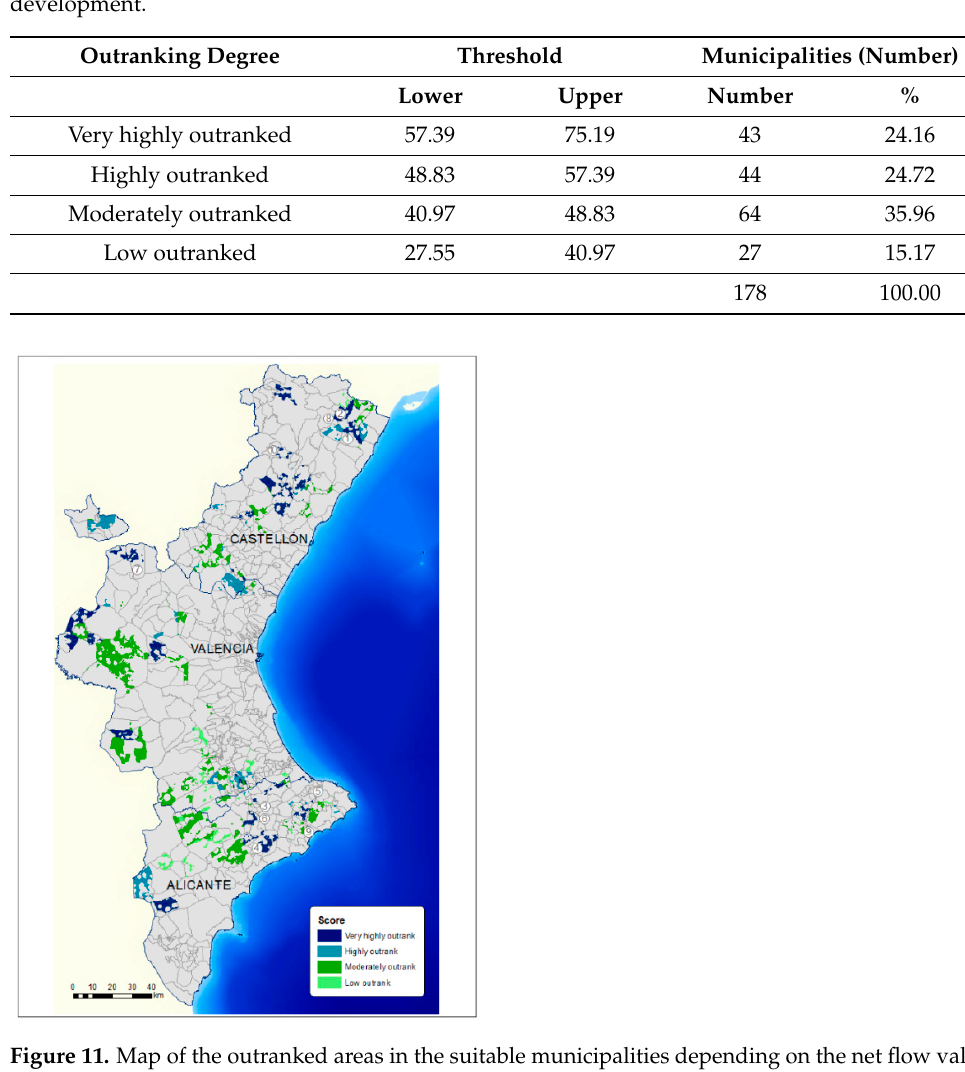
Table 8. Classification criterion for evaluating municipalities with land suitable for the swine sector development.